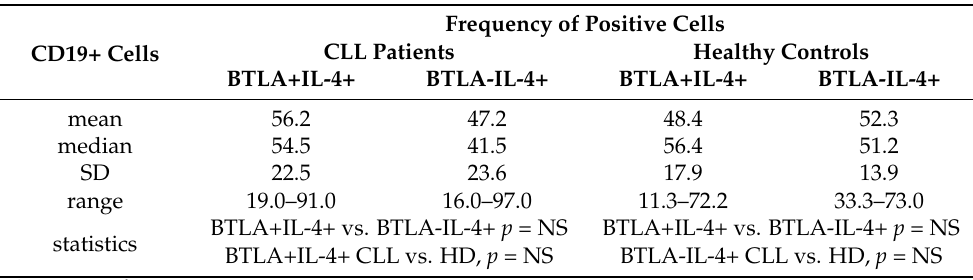
Table 2. Proportion of BTLA positive IL-4 expressing cells and BTLA negative IL-4 expressing cells in B cell compartment in CLL patients and healthy controls.